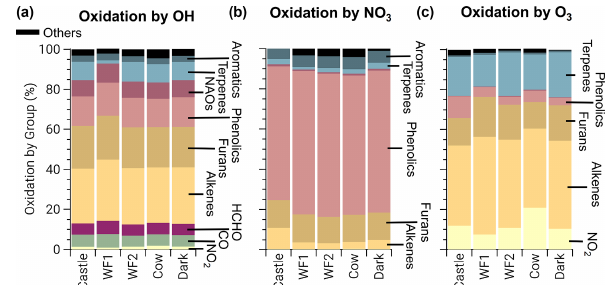
Figure 4. Integrated oxidation rate or oxidation budgets of BB- VOCs by OH (a) , NO 3 (b) , and O 3 (c) on a relative scale for all five model runs. Oxidation by OH is spread across many BBVOC groups (where NAOs are non-aromatic oxygenates), similar to ini- tial reactivity but also HCHO, CO, and NO 2 . Oxidation by NO 3 is dominated by phenolics but by a greater fraction than initial reac- tivity suggests. Oxidation by O 3 is shown without NO and is dom- inated by alkenes and terpenes as expected from initial reactivity, but unlike initial reactivity it includes large contributions from phe- nolics and NO 2 (resulting in NO 3